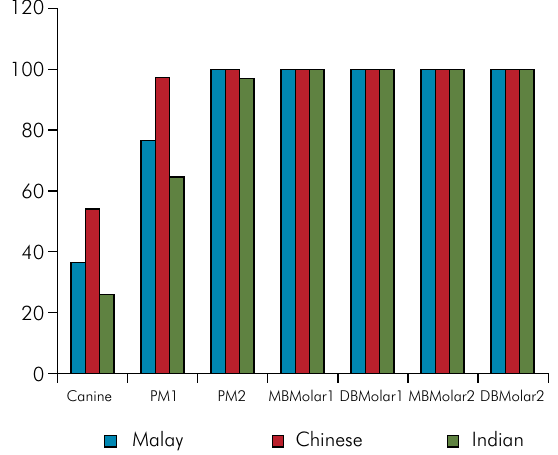
Figure 2. Percentage of sites with the presence (encroachment) of the maxillary sinus, thus enabling measurement of the buccofacial sinus wall to be